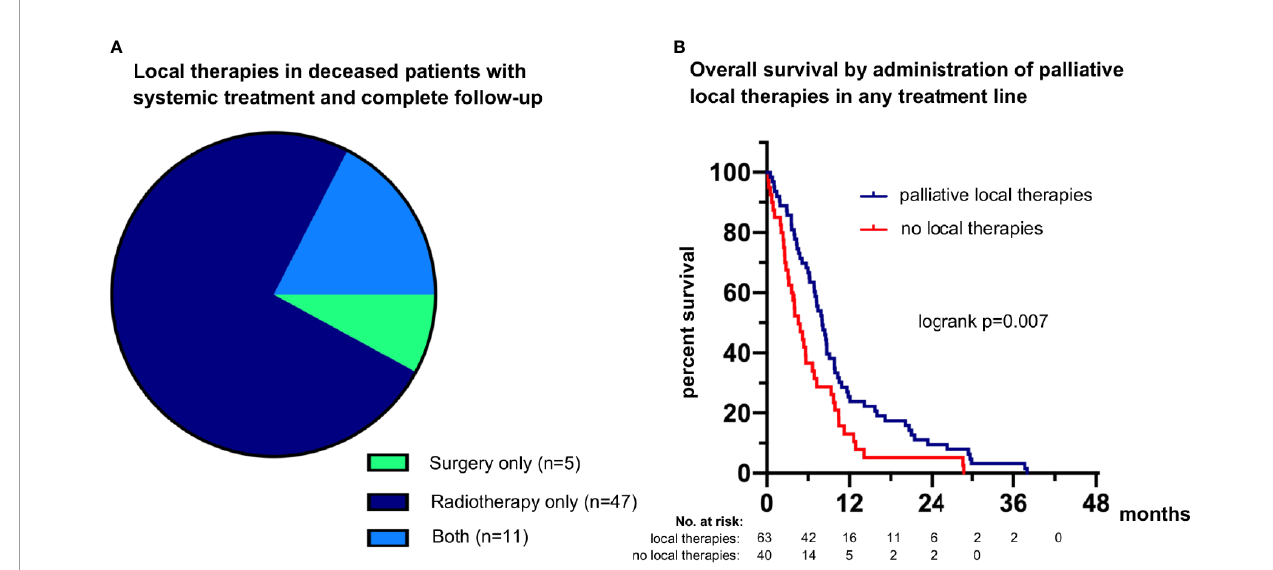
FIGURE 7 | Palliative local therapies and their association with survival in metastatic LCNEC. (A) 75% of patients (47/63) received palliative radiotherapy only, 8% of patients (5/63) received palliative surgery, and 17% of patients (11/63) received both ( Table 1 ). (B) The median overall survival (OS) was 8.1 (95% con fi dence interval 6.5-9.6) months for patients who received palliative local therapies during any treatment line vs. 6.9 (5.6-8.2) months for patients who did not (logrank